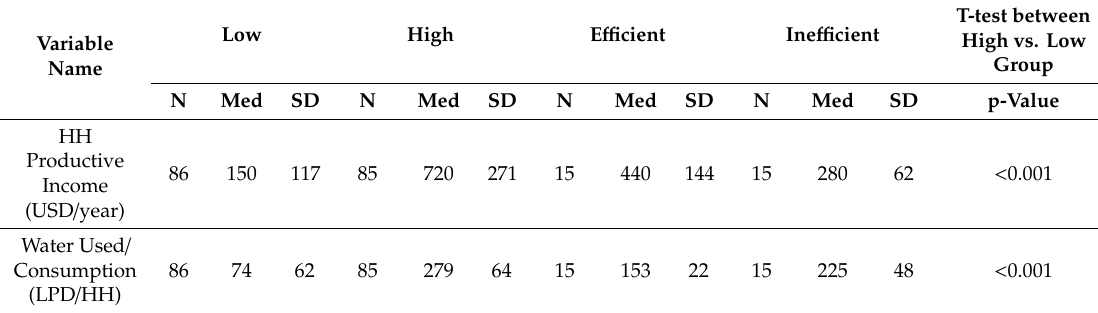
Table 2. Descriptive statistics for four levels (low, high, e ffi cient, and ine ffi cient) of households.